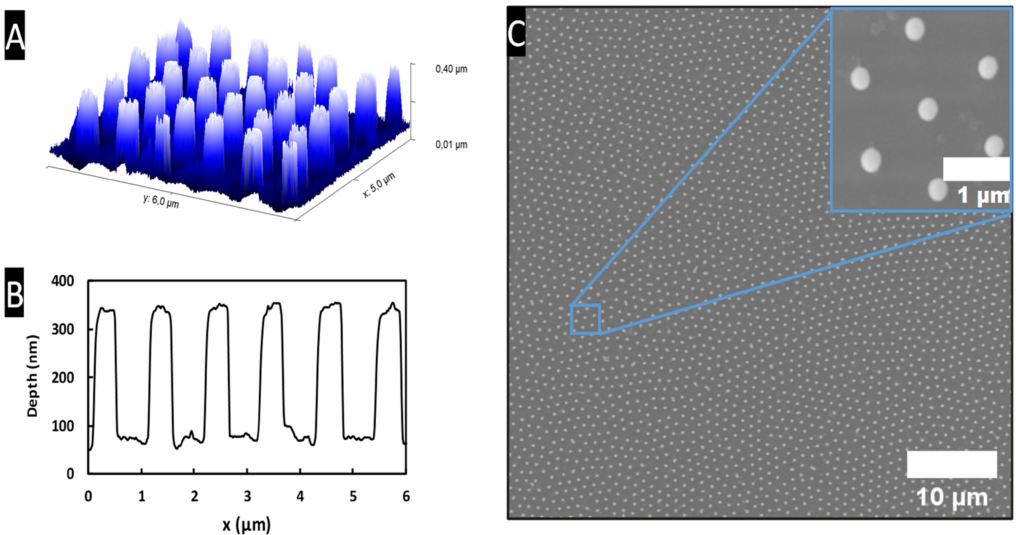
Figure 3. Illustration of the micro-nanostructuring process by colloidal lithography. After homogeneous deposition of the silica microspheres following a 2D periodic hexagonal arrangement (in both x and y directions), the substrate was then illuminated with homogeneous UV light to create the nano-pillars (cylinder-shaped in the z direction) with an arrangement also following a 2D hexagonal pattern (Figure 4C). Each microsphere behaves like a micro-lens by focusing incident UV light and creates a photonic nano-jet that emerges underneath the microsphere in the ZrO 2 layer [35]. After development and thermal stabilization of the ZrO 2 layer at 110 ◦ C for 1 h, a nano-structuring composed of nano-pillars is obtained within the hexagonal arrangement imposed by the nano-sphere deposition.